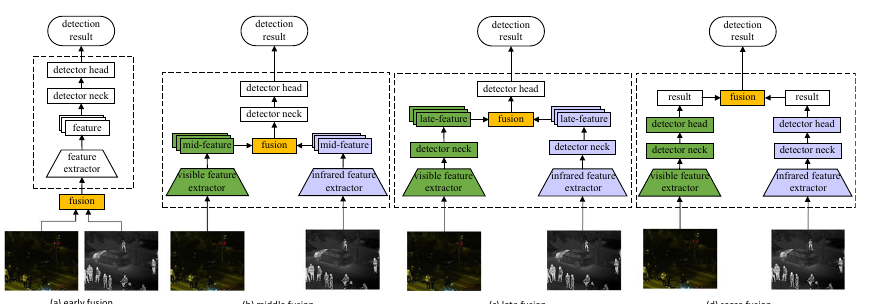
Fig. 2 Four forms of visible and infrared images